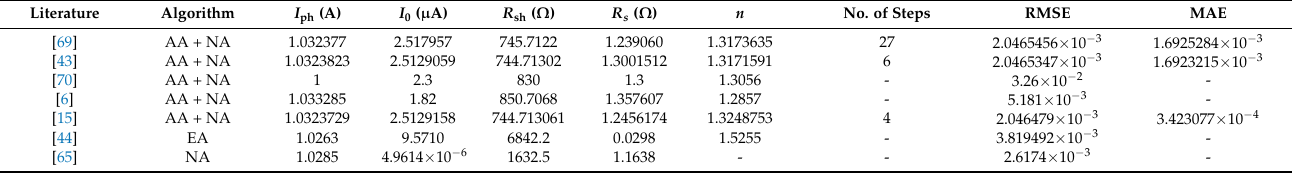
Table 2. Comparison of the parameters obtained in Case Study